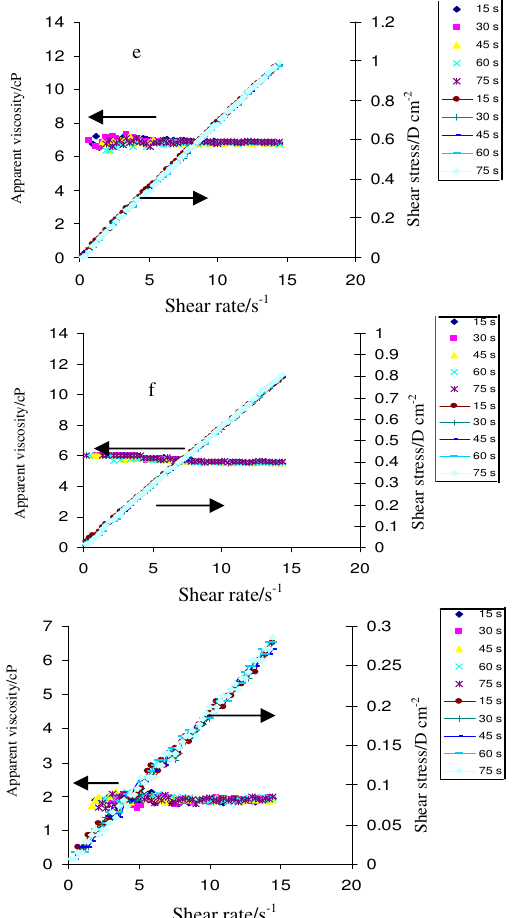
Figure 3. The influence of the shear rate and shearing time on the rheological curves of (a) pure chitosan solution; (b) (90/10); (c) 80/20; (d) 70/30; (e) 60/40; (f) 50/50 and (g) pure PVA solutions at 40 o C